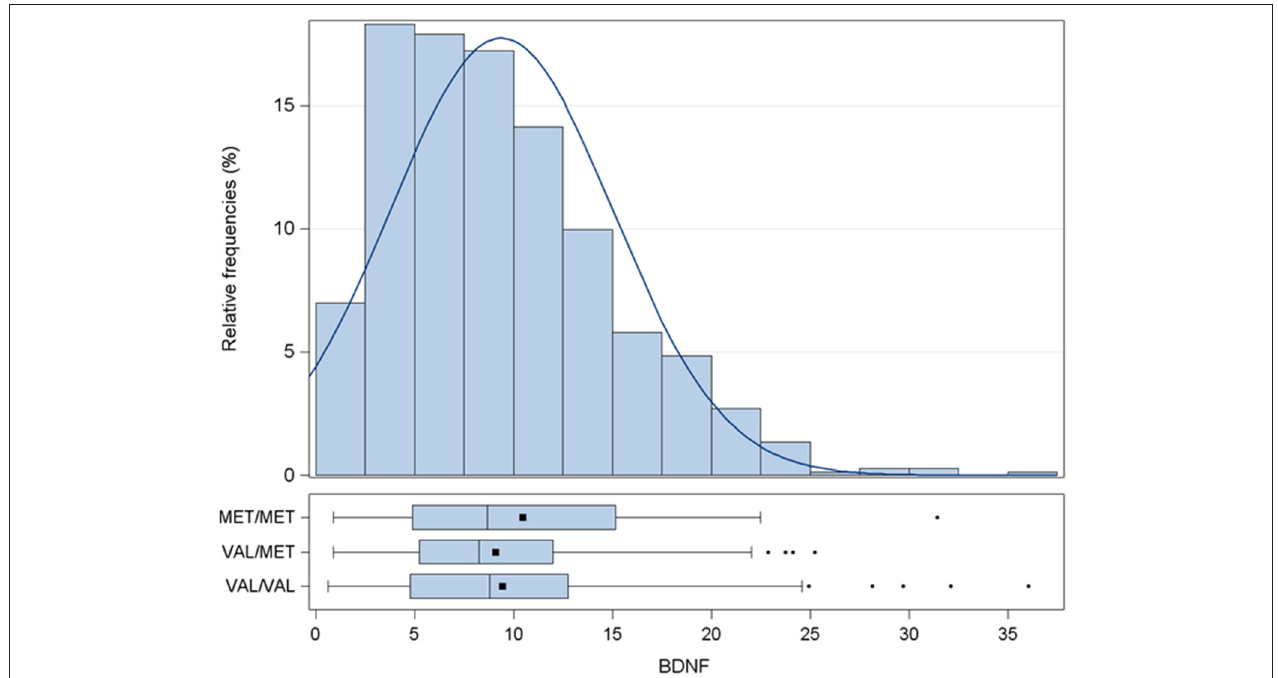
FIGURE 1 | Distribution of BDNF levels (pg/mL). Data are presented as histogram and box-plot grouped by BDNF rs6265 SNP. MET/MET stands for carriers of BDNF Met / Met ; VAL/MET stands for carriers of BDNF Val / Met ; VAL/VAL stands for carriers of BDNF Val / Val . BDNF, brain derived neurotrophic factor; SNP, Single Nucleotide